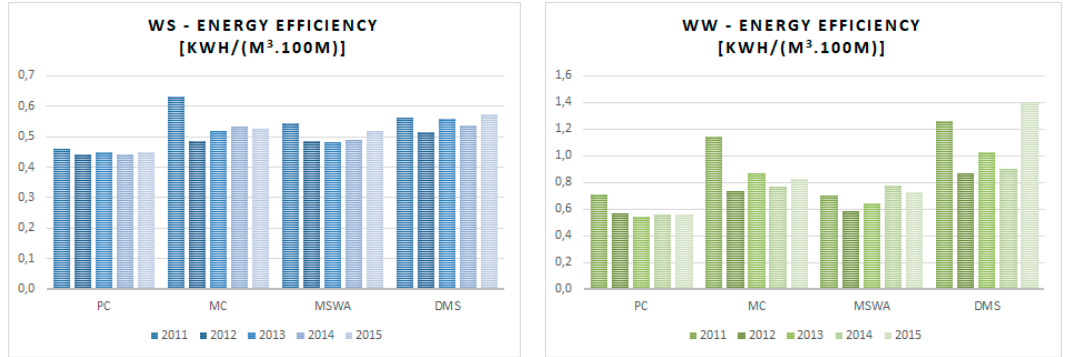
Figure 9. Evolution of energy efficiency in water (left) and wastewater services (right).